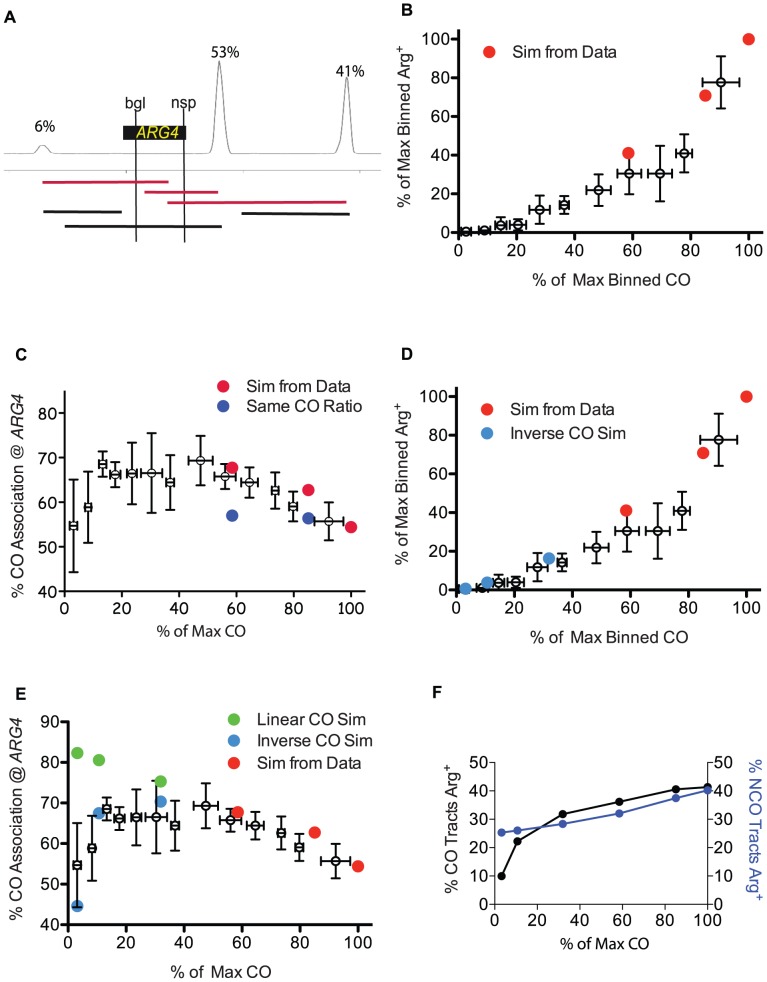
Simulation of genetic data from sequencing analysis.A. Diagram of the DSB location and usage around ARG4, showing three prominent hotspots with relative intensities of 6, 53 and 41 (left to right) [38]. The locations of the ARG4 heteroalleles are shown; tracts that end between the alleles are capable of forming a prototroph. Examples of tracts that begin at a hotspot and end within the two heteroalleles are capable of forming an Arg+ are shown as red lines. Black lines depict examples of tracts that cannot form Arg+. B. Arg prototroph frequencies are plotted against normalized CO frequencies. Binned genetic data from Figure 3A is presented as empty symbols. Simulated values based on data from WT, HI and LO tetrads are indicated in red circles. C. The percentage of Arg prototrophs with a CO is plotted against CO frequencies. Binned genetic data from Figure 3C (empty symbols) are plotted with simulated data for WT, HI and LO tetrads (red circles). Dark blue circles represent simulations of the WT, HI and LO tract lengths but using the wild-type proportion of CO and NCO tracts. D. Same as B, with the addition of light blue circles representing mutants with 30, 10 or 3 COs as the result of extrapolating the tract length parameters (from WT, HI and LO) and performing the same simulations using an inverse regression for extrapolating the mean of the CO tract length distribution (see Materials and Methods). E. Genetic CO association data as in C, but including simulated values for virtual mutants with 30, 10 or 3 COs using an inverse regression (light blue circles) or linear relationship (green circles) (see Materials and Methods for calculations and explanation). F. Simulated CO and NCO tracts from mutants of varied Spo11 activity (WT, HI, LO, 30, 10 and 3) were scored for their ability to produce “virtual prototrophy” at ARG4.